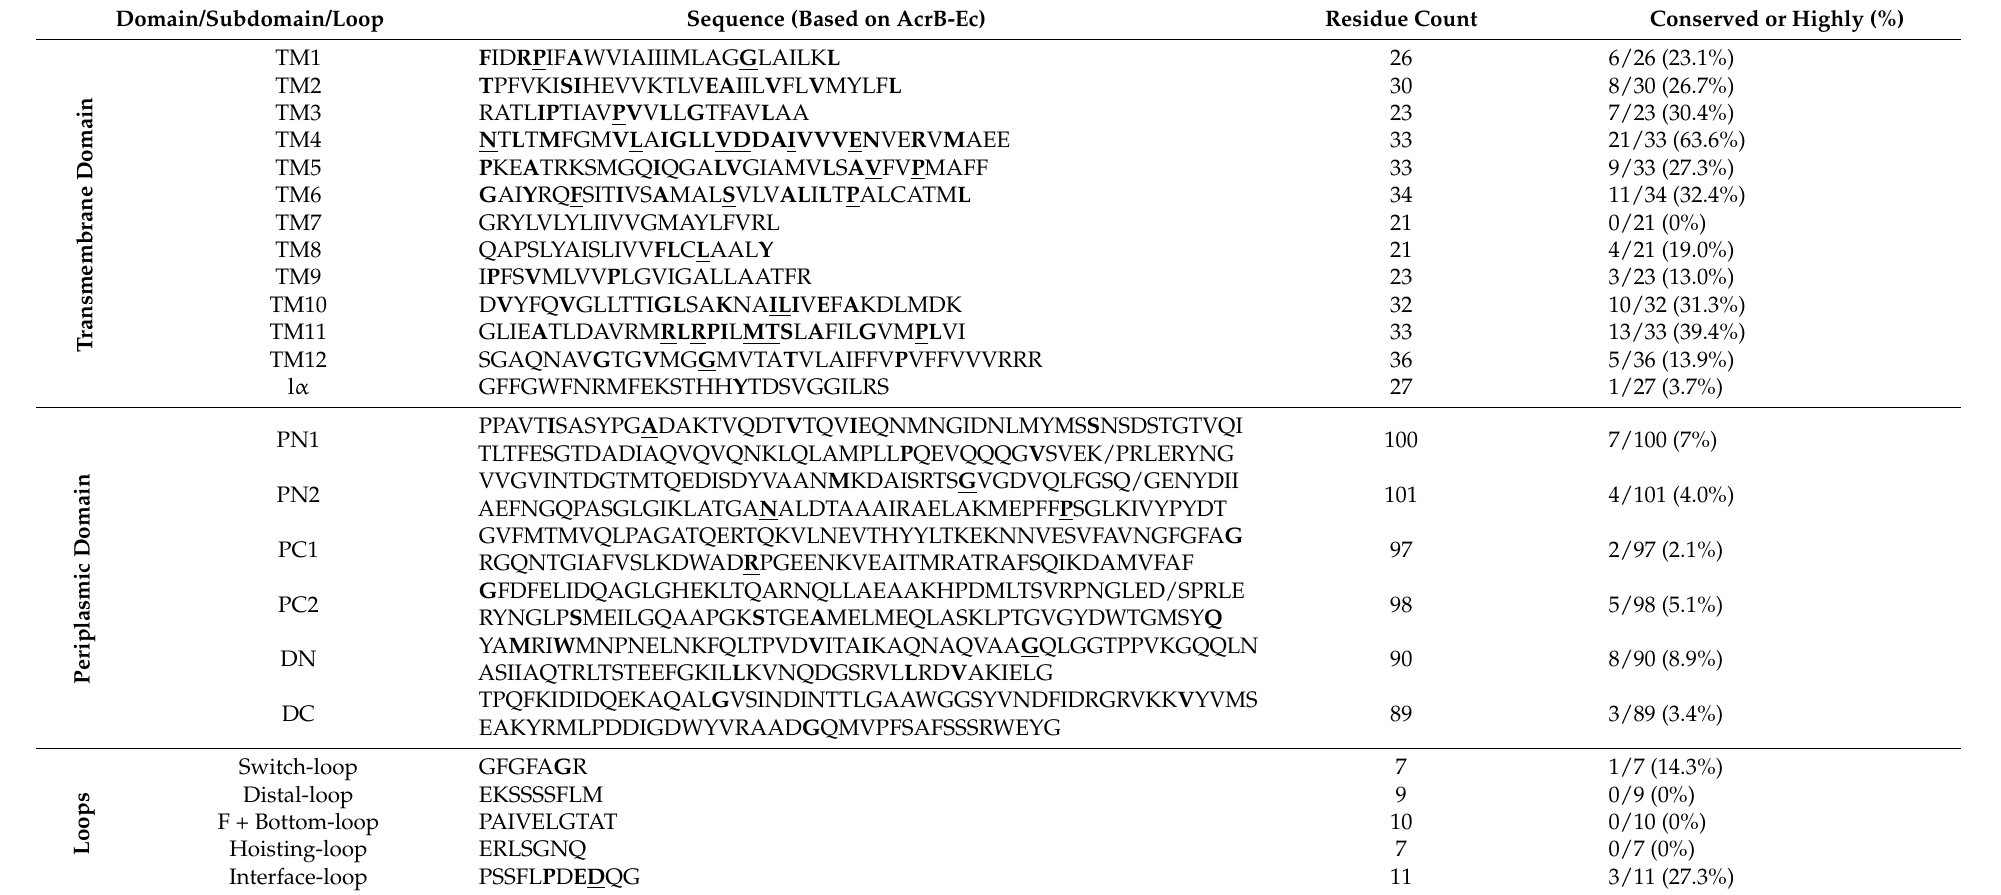
Table 1. Conservation and similarity between 135 MDR RND-type efflux